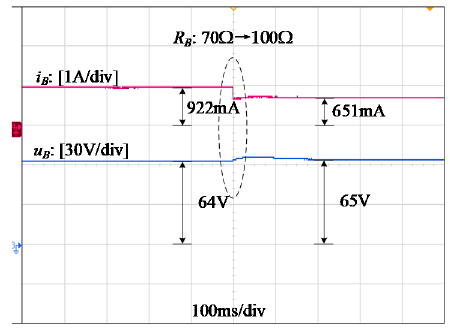
Figure 16. Transient waveforms from 70 Ω switch to 100 Ω at CV mode.